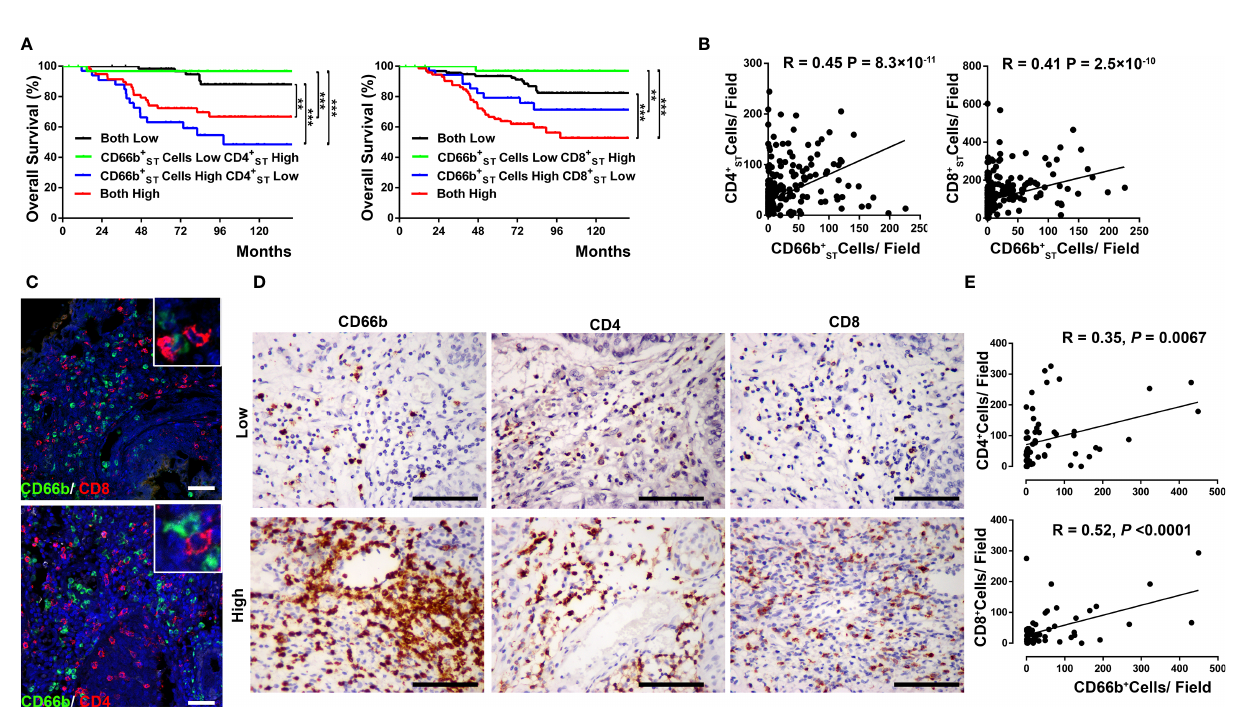
FIGURE 2 | Co-localization of stromal neutrophils and T cells associated with Overall survival. (A) Kaplan-Meier overall survival (OS) curves were designed according to high- and low-density of combined stromal CD66b + neutrophil and CD4 + T cell in fi ltration or combined stromal CD66b + neutrophil and CD8 + T cell in fi ltration. Patients with high levels of CD4 + /CD8 + T cell in fi ltration alone had a signi fi cantly better OS than patients with high levels of combined CD4 + /CD8 + T cell and neutrophil in fi ltration. P -values were determined using a log-rank test. ** P < 0.001; *** P < 0.0001. (B) Positive associations between the number of CD66 + ST cells and CD4 + ST cells, CD66 + ST cells and CD8 + ST cells (n = 237). (C) Representative pictures showing the co-localization of neutrophil (CD66b, green) and T cell markers (CD4 and CD8, red) in the stromal (ST) regions of UCB tissues. (D, E) Consecutive sections were used for the immunohistochemical identi fi cation of stromal CD66b + cells, as well as CD4 + T cells and CD8 + T cells in UCB tissues (n= 57). P < 0.05 was considered signi fi cant difference (Spearman ’ s rank correlation coef fi cient test). Representative examples of tumors with either low (top) or high (bottom) expression of neutrophil (CD66b), T cells (CD4 and CD8) markers are shown. Scale bar: 100 m